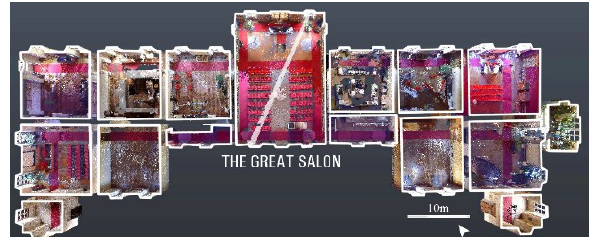
Figure 3. A plan of the complete LiDAR point cloud in the first floor of the Valentino Castle (the cloud is cut at + 2.5 m above the pavement). (Image by LabG4CH, Polito)